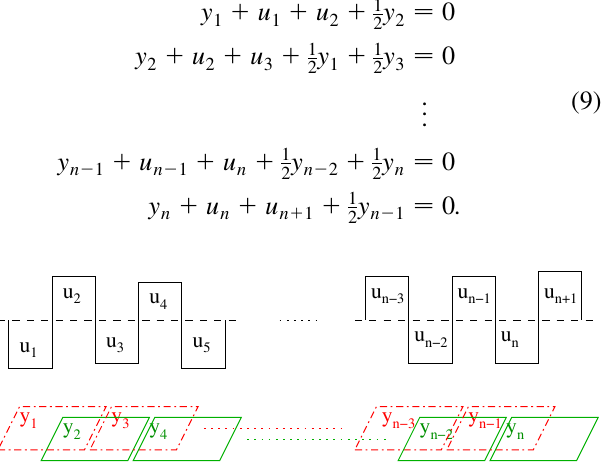
FIG. 2. (Color) Rectangular flux with n þ 1 half periods and n overlapping closed